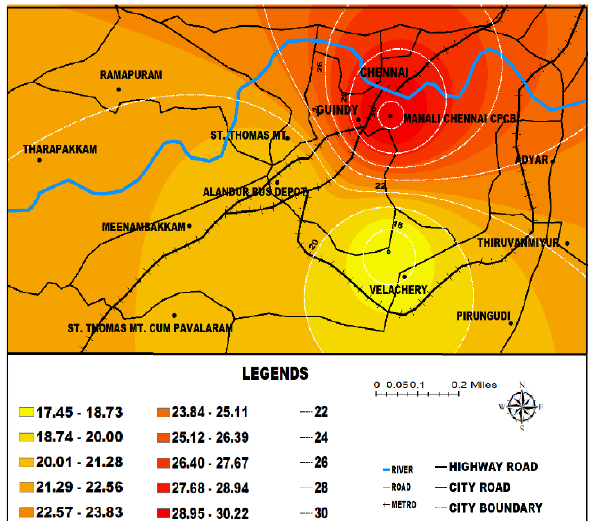
Figure 17. Air quality map of Chennai August monthly average based on NOx (µg/m 3 ).